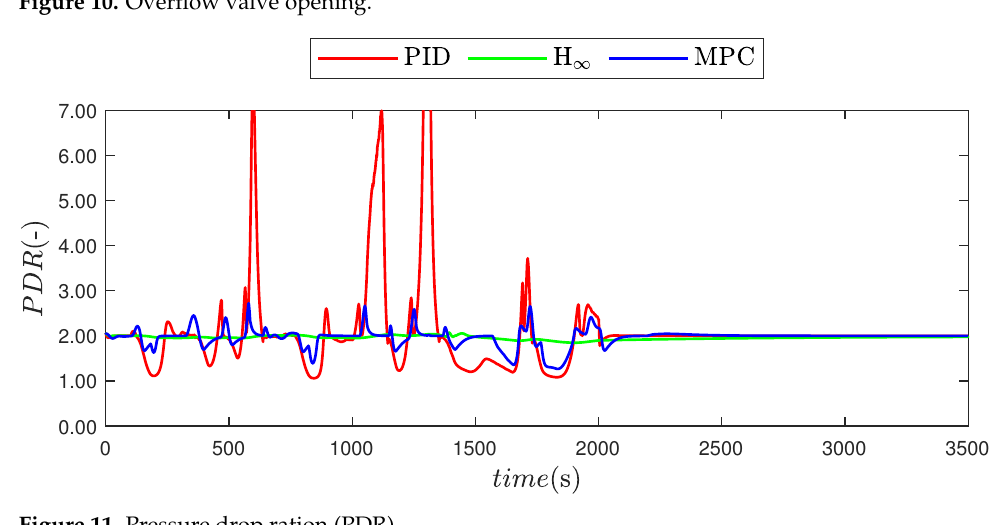
Figure 10. Overflow valve opening.